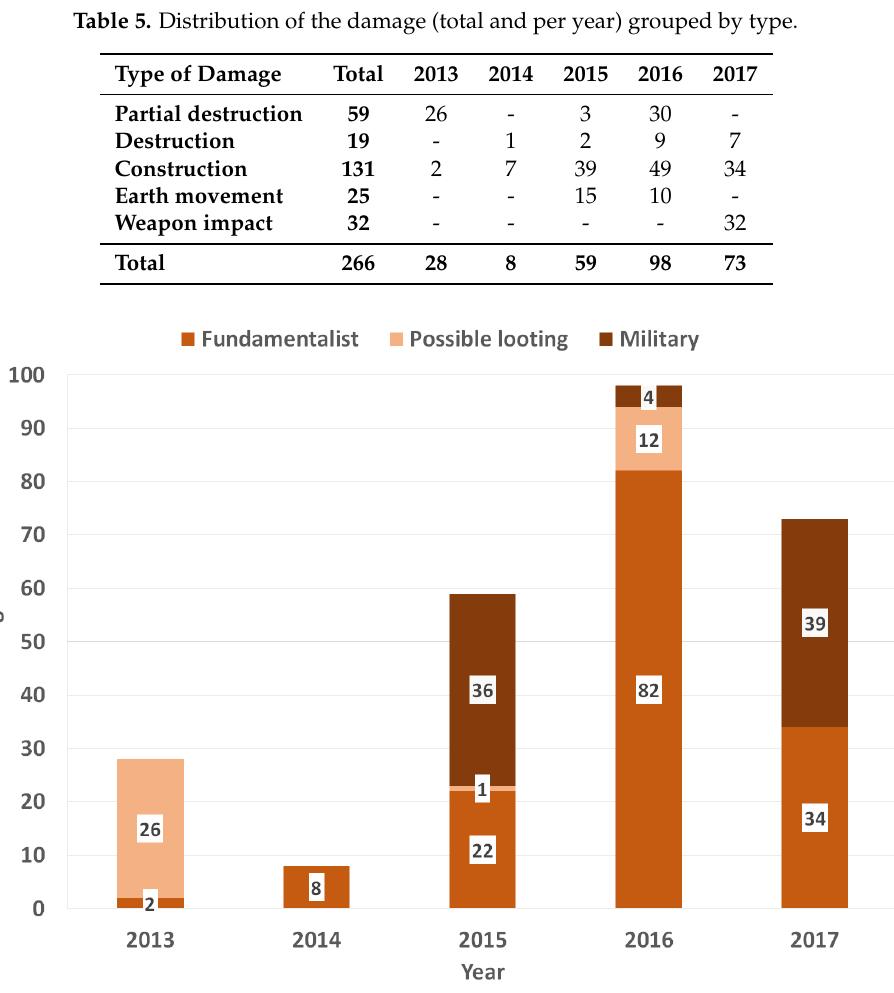
Figure 12. Distribution of damage by category observed over the entire period (November 2013–March